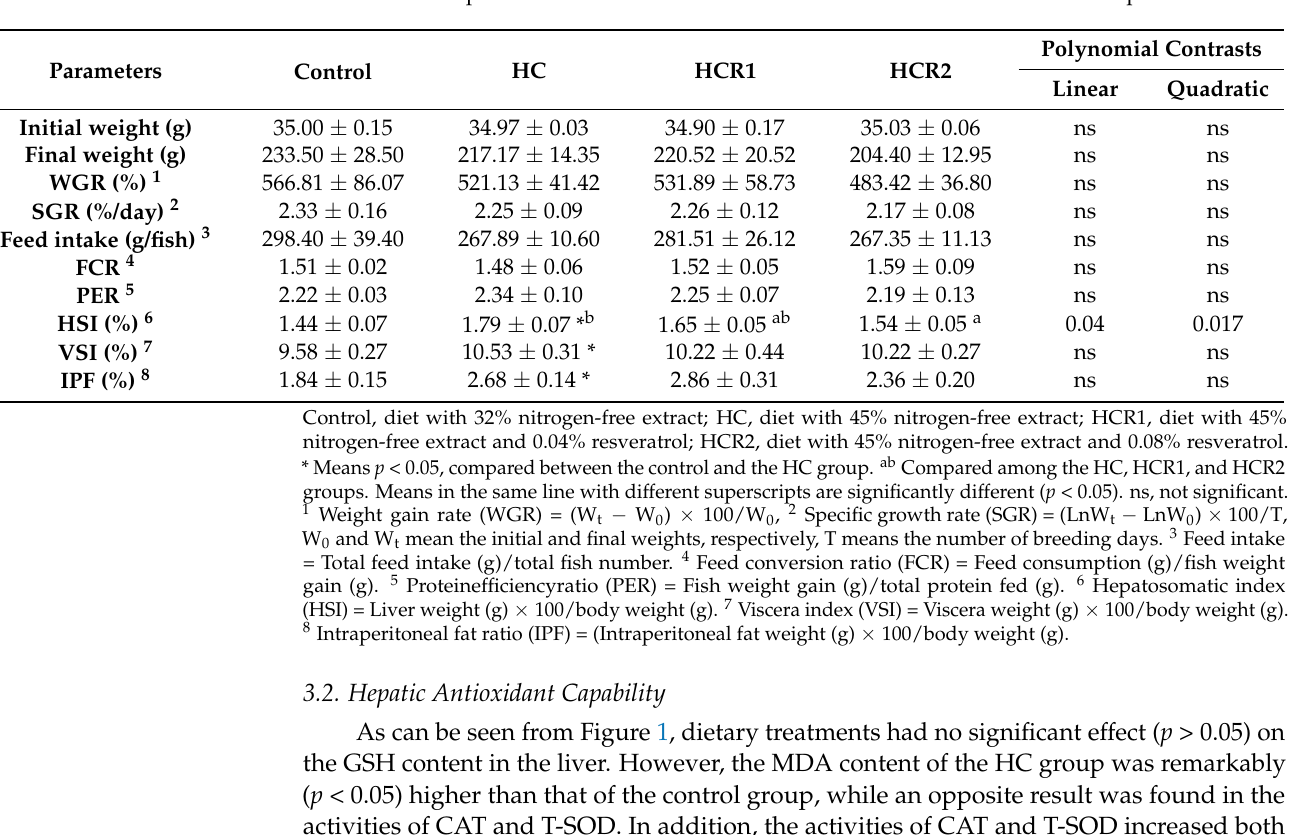
Table 3. Growth performance and feed utilization of blunt snout bream fed different experimental diets.